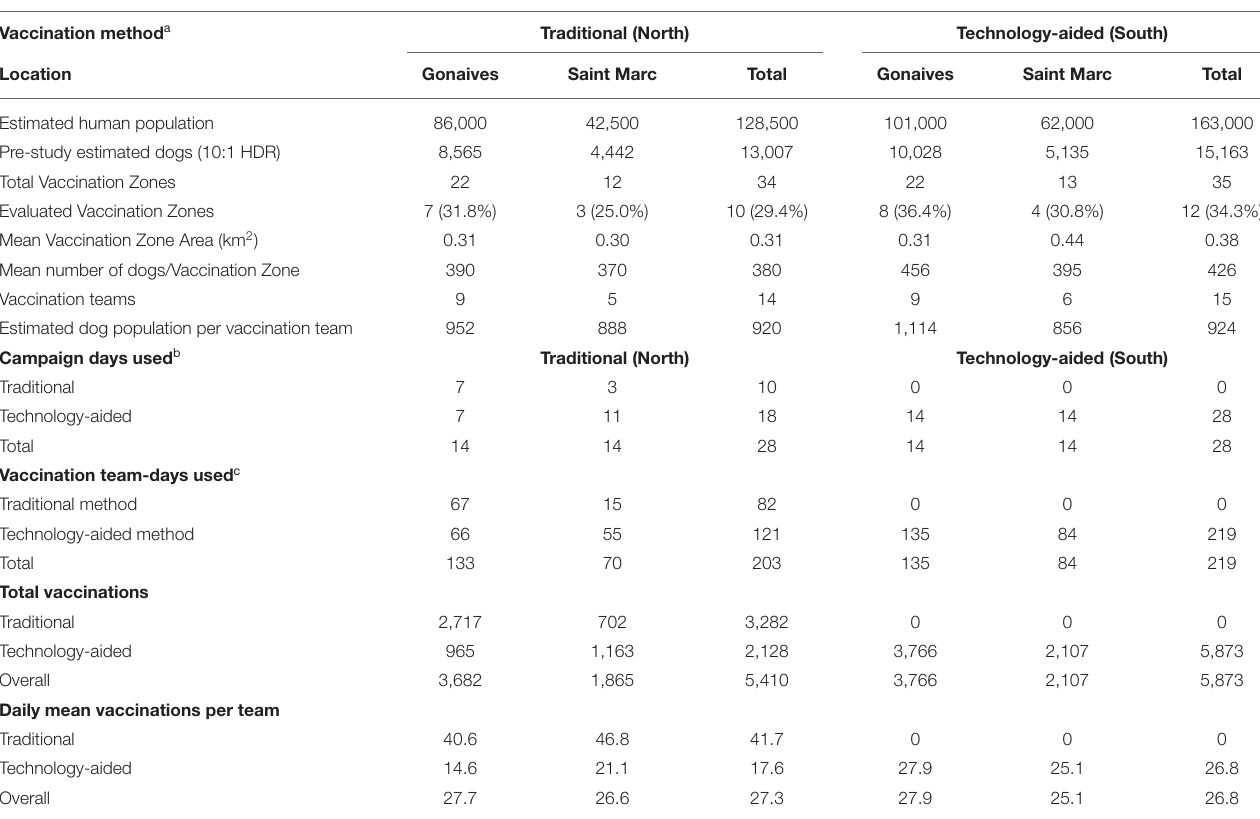
TABLE 1 | Summary characteristics for each vaccination area.